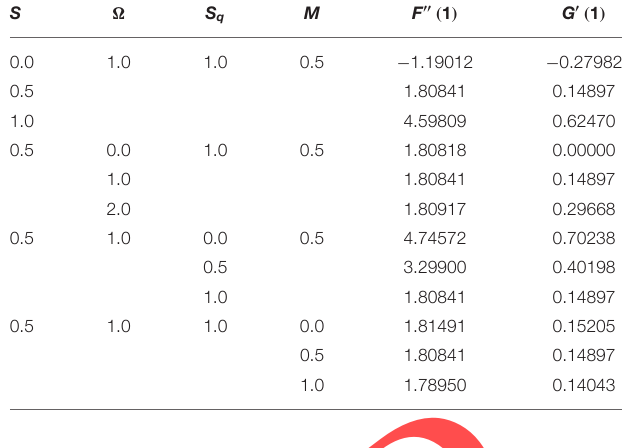
TABLE 2 | Numerical data for local Nusselt number and local Sherwood number for varying S , (cid:127) , S q , M , Ec , Sr , Df , Sc , and